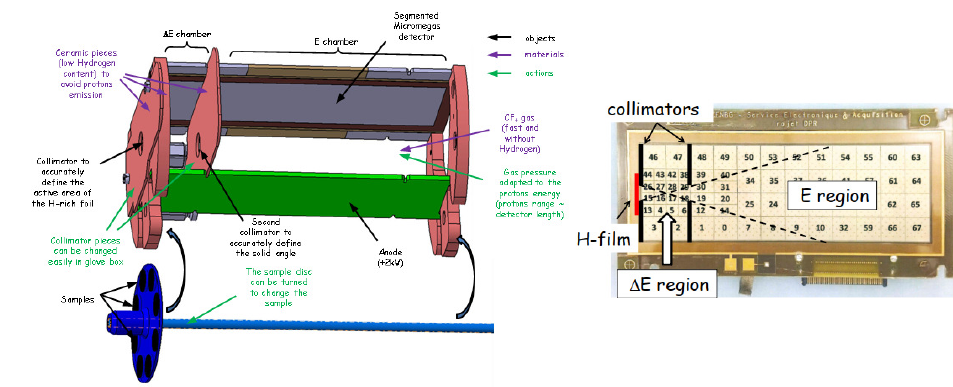
Figure 1. Schematic layout of the detector (left) and of the detection plane (right). The sample disk is shown separately for clarity